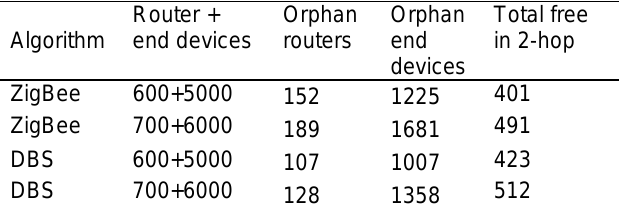
Table 2 Table of associated, orphan and free routers within 2-hop for complete